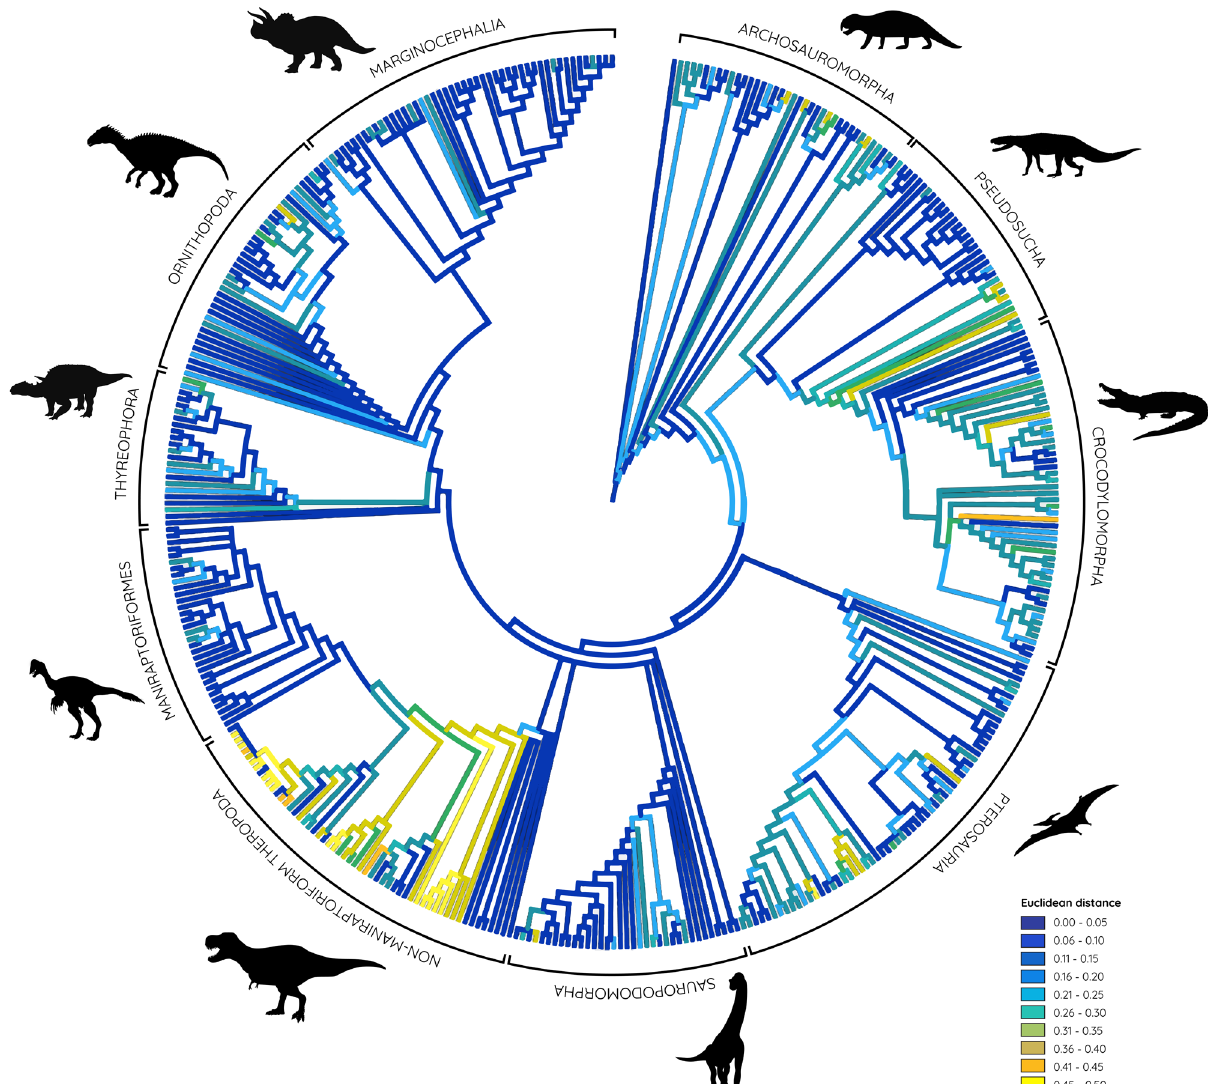
Fig. 4 Composite phylogenetic tree of analysed species. Euclidean distances representing different orbit shapes (circular = 0, compressed, keyhole- shape, etc. = 0.5) mapped onto phylogeny highlighting occurrences of non-circular orbit